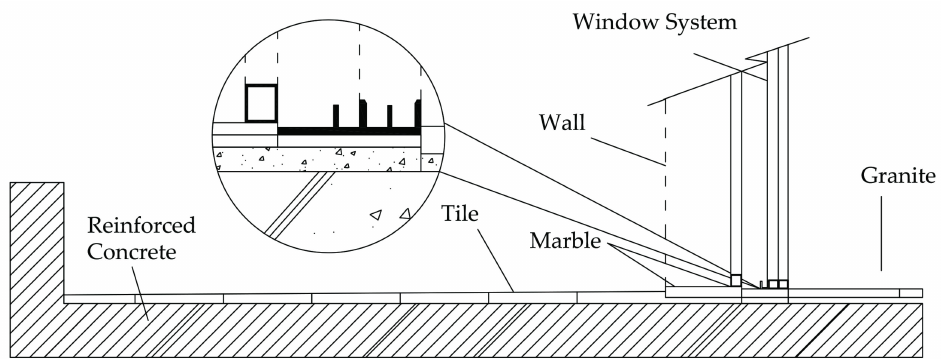
Figure 1. Measurements at the study area.